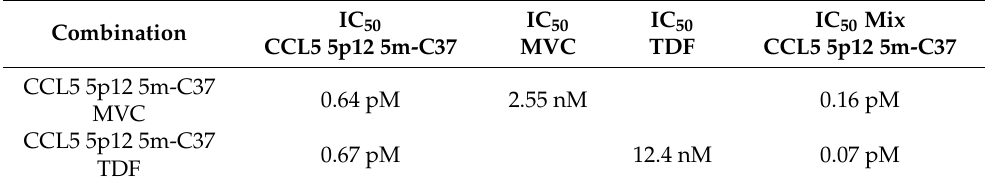
Table 3. IC 50 in